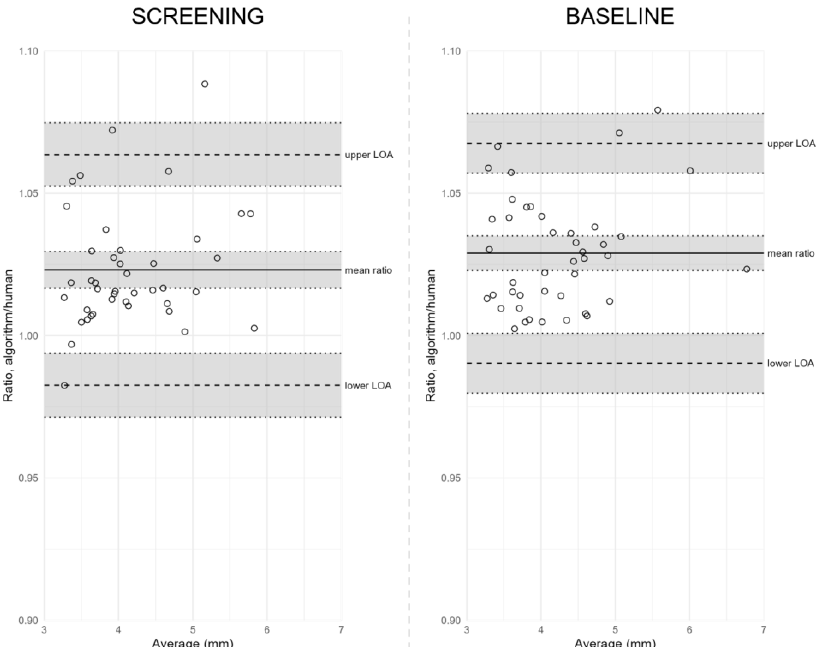
Figure 5. Bland–Altman plots of agreement between reading methods under mesopic conditions using ratios. Notes: Bland–Altman plots of agreement between reading methods under mesopic conditions at screening (left) and baseline (right) using ratios. Ratios between human-assisted read- ing and automated reading are plotted against their averages. The solid line marks the mean ratio of pupil size between human-assisted reading and automated reading, the dashed lines mark the lower and upper limits of agreement (LOA), and grey shaded areas cover 95% CI of calculated esti- mates. Abbreviations: CI = confidence interval; LOA = limits of agreement. Under photopic conditions, the mean difference between visits was −0 .01 mm (95% CI, −0 .05 to 0.03), with LOA from −0 .25 mm (95% CI, −0 .31 to −0 .18) to 0.23 mm (95% CI, 0.16 to 0.29). The differences and averages were not significantly correlated ( P = 0.82). The agreement coefficients under mesopic and photopic conditions were 0.89 mm and 0.24 mm, respectively, indicating higher reproducibility of photopic measurements when com- pared over time. 3.3. Reproducibility between Human-Assisted and Automated Readings Reproducibility between reading methods was assessed by comparing pupil size measurements captured by human-assisted or automated reading (Table 2 and Figure 4). Under mesopic conditions, we found significant correlations between differences and av- erages at both screening and baseline visits, indicating greater differences between the reading methods with increasing pupil sizes. Under photopic conditions, the mean differ- ence between human-assisted and automated reading of screening measurements was 0.03 mm (95% CI, 0.02 to 0.04), with LOA from −0 .03 mm (95% CI, −0 .05 to −0 .01) to 0.10 mm (95% CI, 0.08 to 0.11) after exclusion of two outliers. A similar agreement was found between reading methods at the baseline visit, with a mean difference of 0.03 mm (95% CI, 0.02 to 0.04) and LOA from −0 .06 mm (95% CI, −0 .08 to −0 .03) to 0.12 mm (95% CI, 0.09 to 0.14). The inter-method repeatability coefficients indicate that the reproducibility be- tween human-assisted and automated readings was higher under photopic conditions at both visits, although the significant correlations from the mesopic measurements compli- cate a direct comparison.